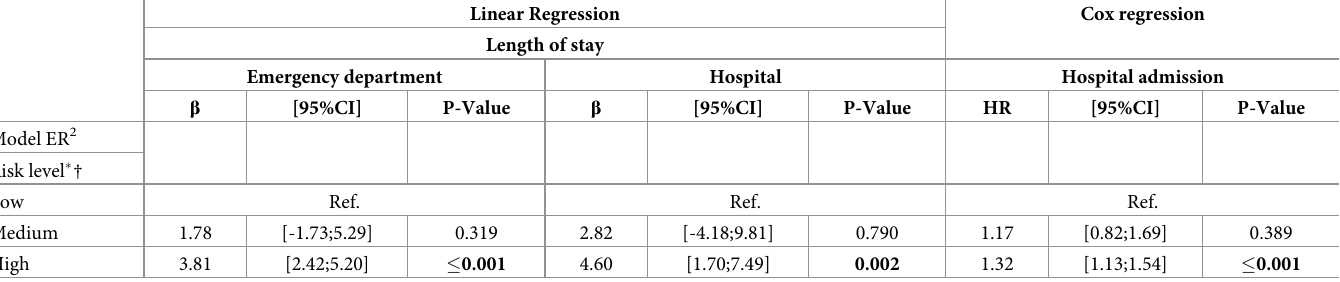
Table 2. Regression models showing the association of the length of stay in emergency department and hospital (linear regression) as well as hospital admission (Cox regression) used as dependent variables with separated model for each outcome with Emergency Room Evaluation and Recommendation risk-levels used